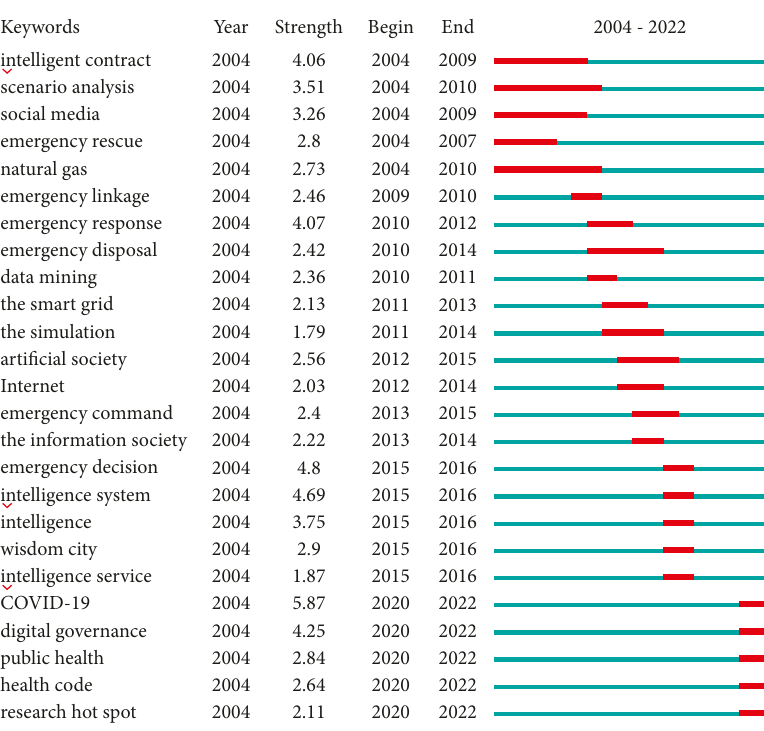
Figure 15: Top 25 keywords with the strongest citation bursts of Chinese DEM